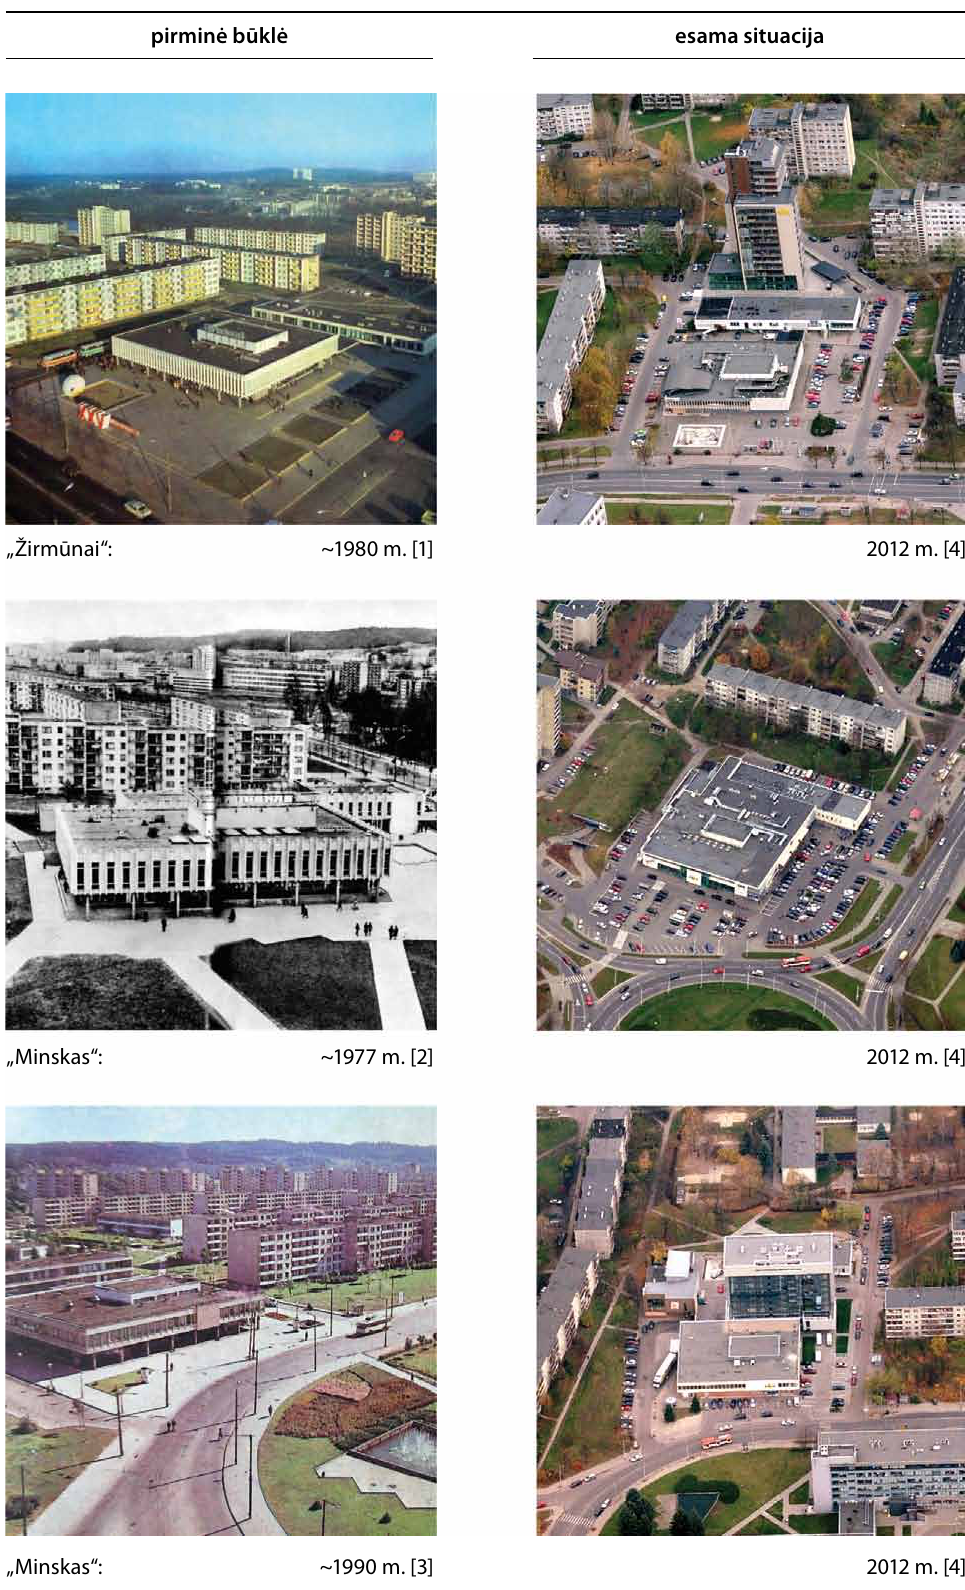
Fig. 4. Chronological Transformations of Public Spaces in Žirmunai residential